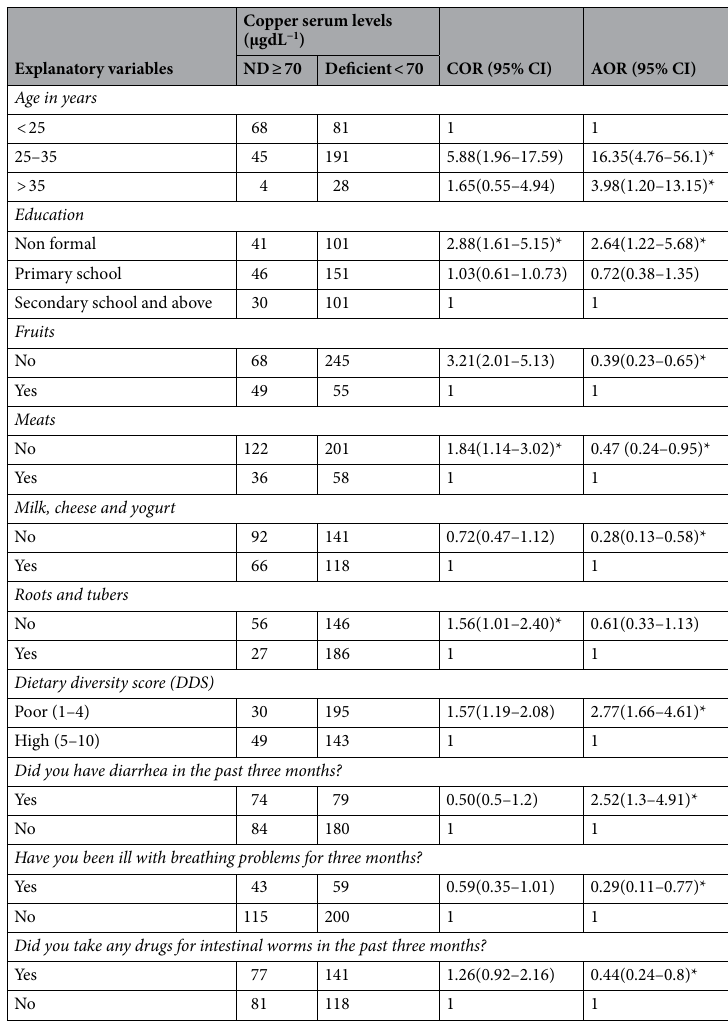
Table 5. Results of logistic regression model for risk factors associated with copper deficiency of pregnant women small-scale farmers in Kellem Wellega zone, western Ethiopia, 2021. AOR adjusted odds ratio, COR crude odds ratio, CI confidence interval, ND non deficient; and *represent the level of significance at p values less than